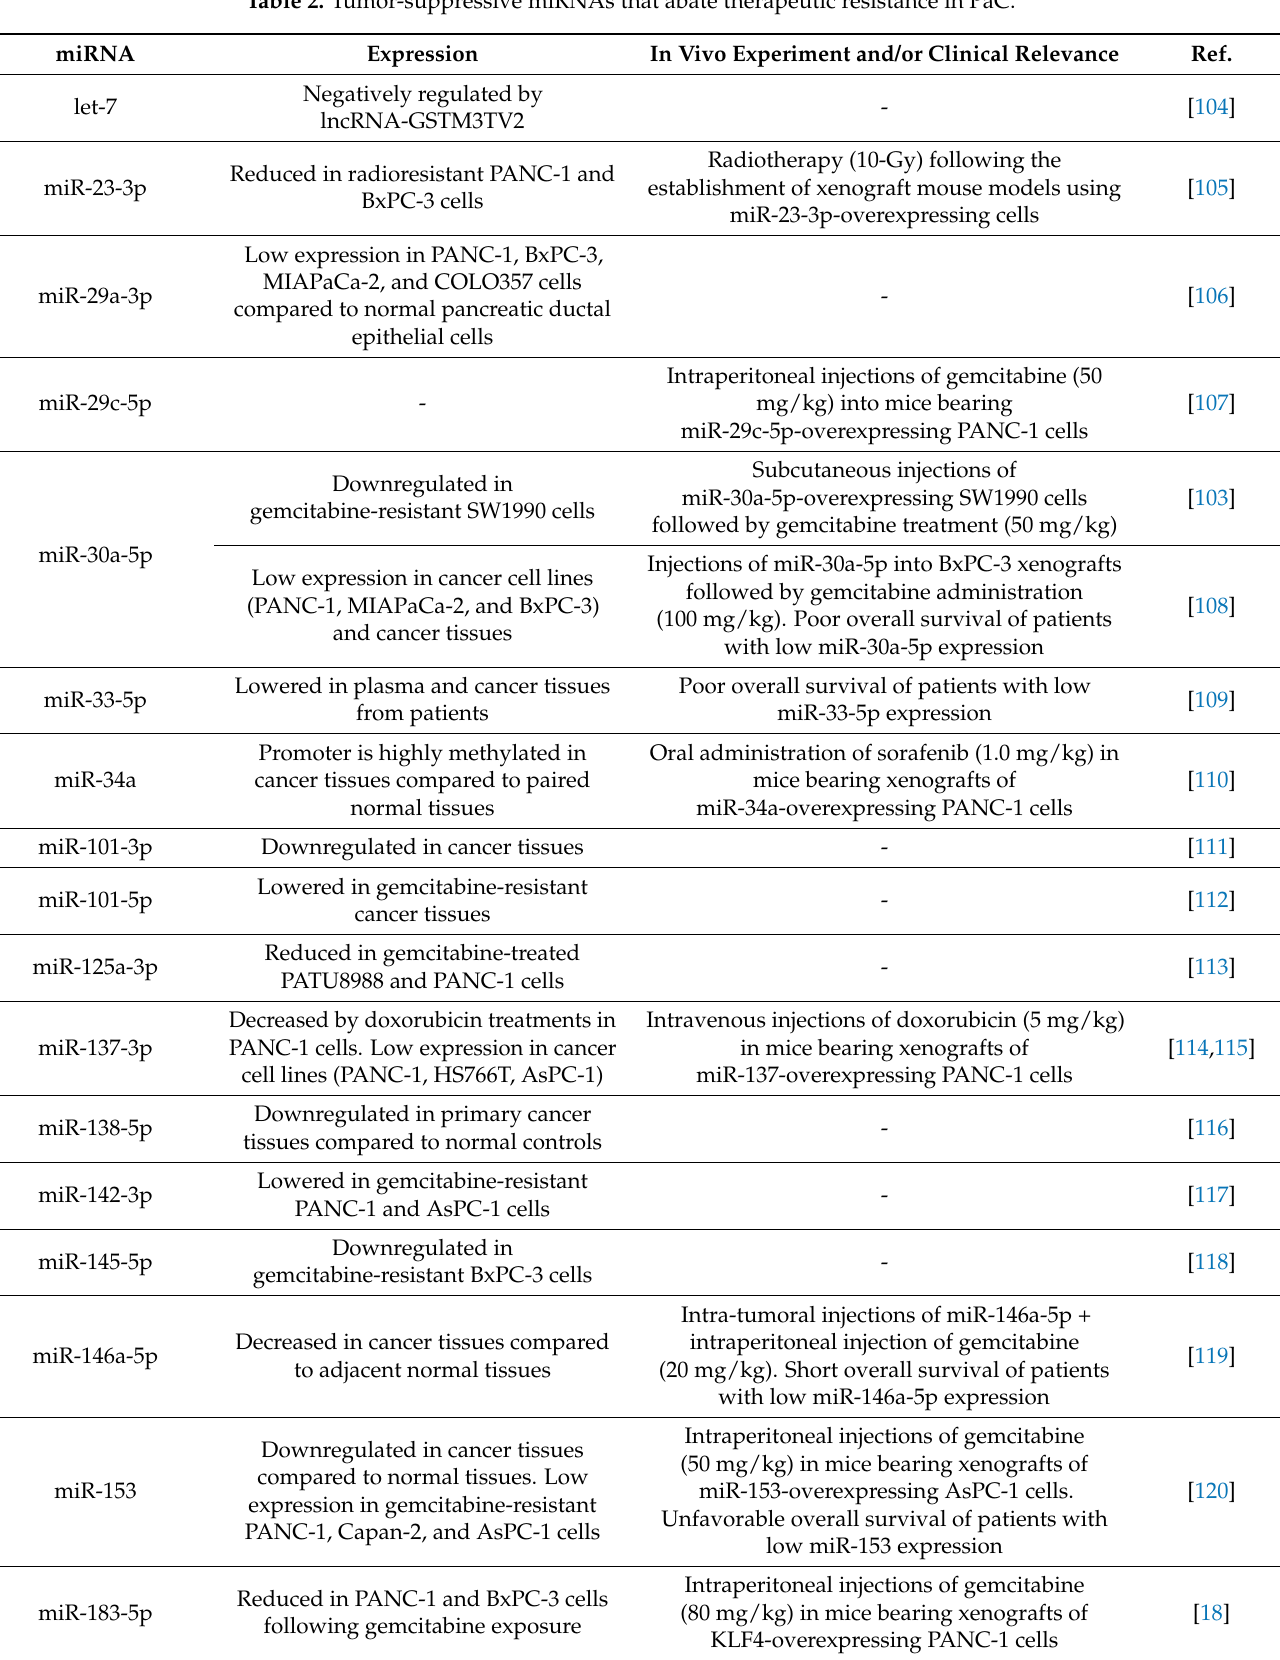
Table 2. Tumor-suppressive miRNAs that abate therapeutic resistance in